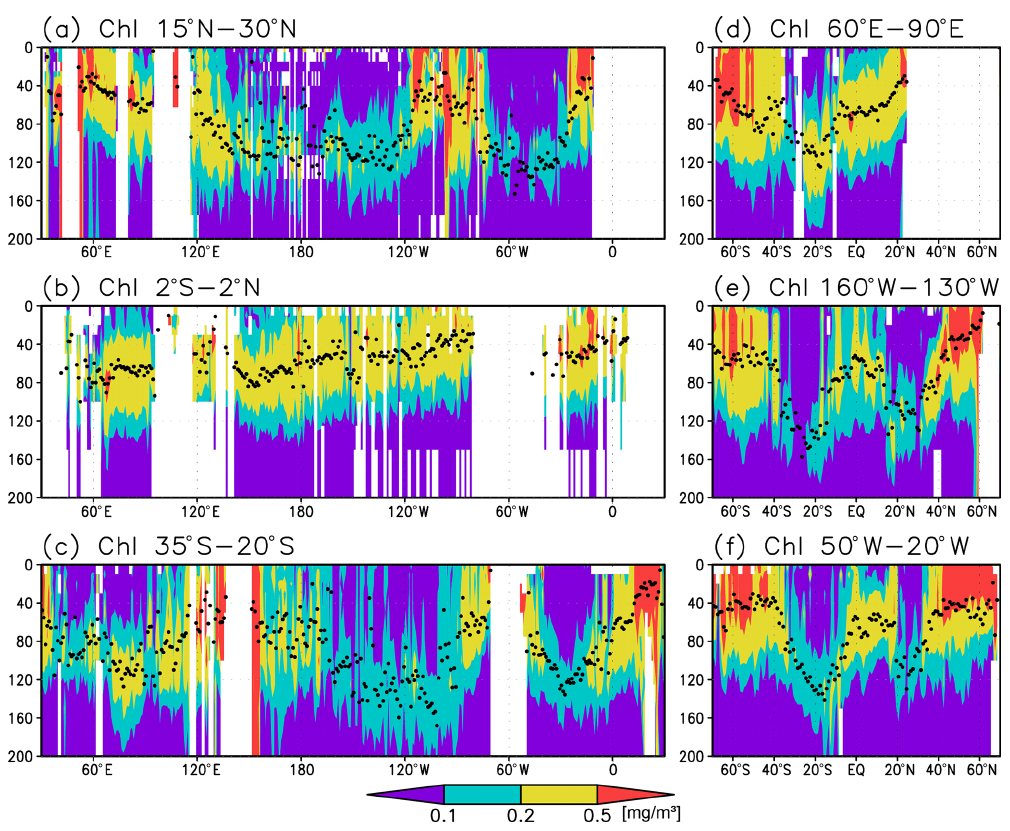
Figure 3. Cross sections of chlorophyll a (Chl a ) concentrations at (a) 15–30 ◦ N (northern subtropics), (b) 2 ◦ S to 2 ◦ N (tropics), (c) 35– 20 ◦ S (southern subtropics), (d) 60–90 ◦ E (the Indian Ocean), (e) 160–130 ◦ W (the Pacific Ocean), and (f) 50–20 ◦ W (the Atlantic Ocean). The black dots indicate the depth of the Chl a maximum.